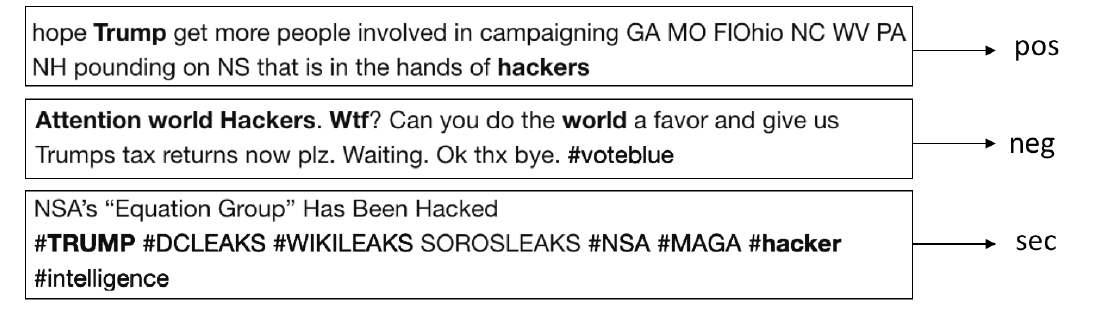
Figure 4. Example of labeling for the three observed